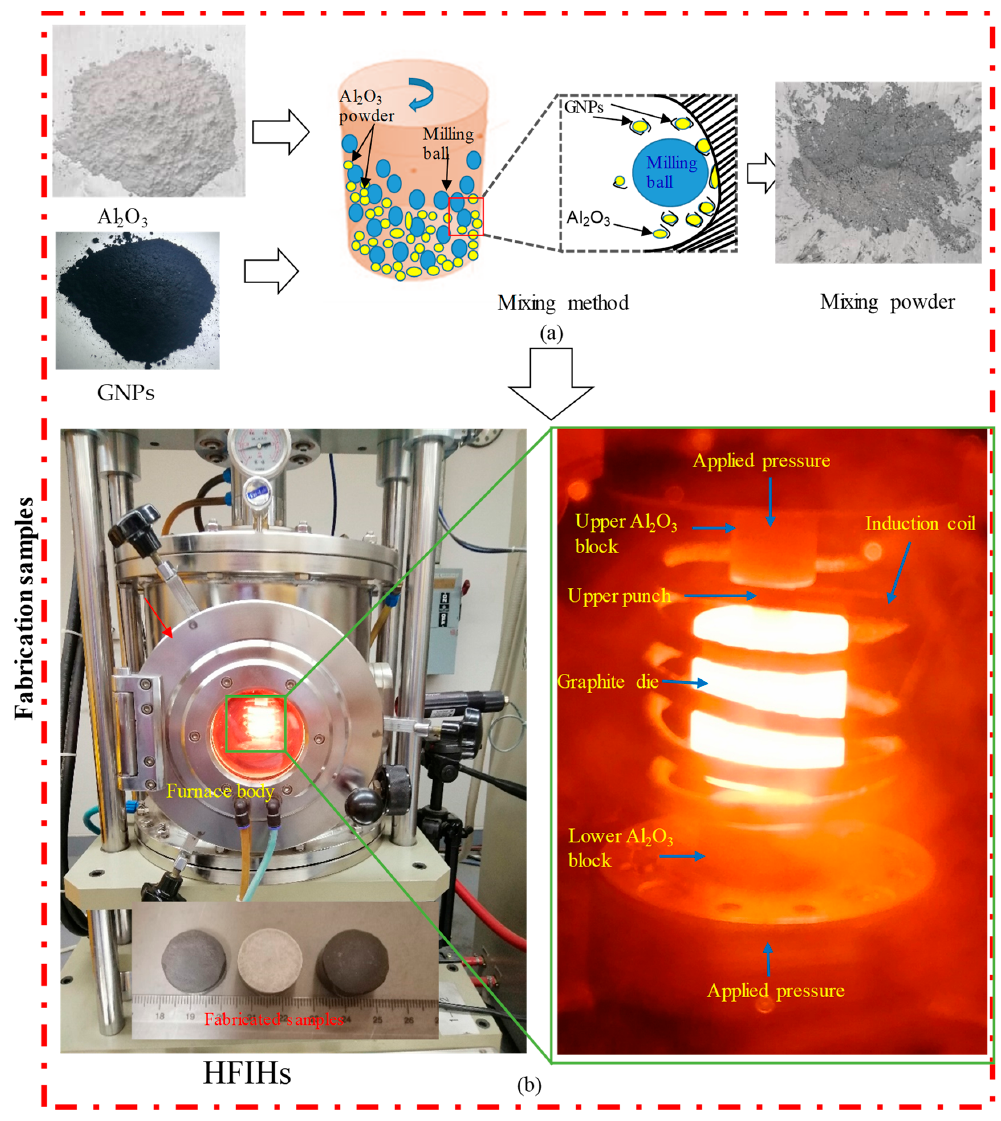
Figure 2. Experimental setup for fabricating the GNP/Al 2 O 3 specimens.